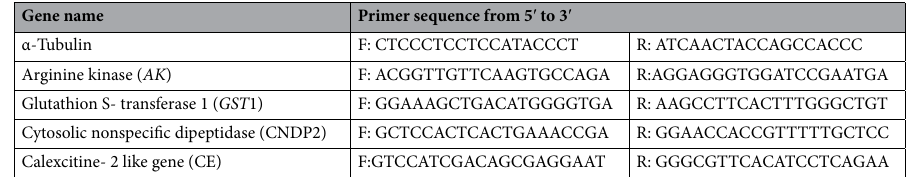
Table 1. Quantitative PCR primers